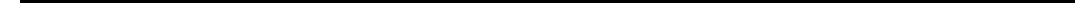
Fig. 4 – The Cre/ loxP system and its applications. The loxP site, symbolized by a triangle is a sequence of 34 base pairs composed of palindromic sequences of 13 pb separated by a sequence of 8 pb (A). Cre recombinase specifically recognizes this sequence, provokes the cleavage in DNA (vertical arrows, A) and induces the recombination of DNA between the two loxP sites as illustrated in B. This reaction is reversible. Several types of recombination events can be produced depending on whether the two loxP sites are carried by the same DNA molecule (recombination in cis) or by two different DNA molecules (recombination in trans) and depending on the respective orientation of the two loxP sites (the orientation of a loxP is given by the non-palindromic 8 pb sequence). Recombination in cis (C). If the two loxP sites have the same orientation, the DNA region situated between these sites is deleted during recombination. This type of configuration is used to create ‘‘clean’’ mutations (elimination of the selection cassette, see Fig. 3), conditional mutations (see Fig. 5) and deletions. If the orientation of the two loxP sites is opposed, recombination leads to the inversion of the region comprised between the two sites. Recombination in trans (D). If one loxP site is integrated in the genome and the other is carried by a circular plasmid, there may be an insertion of sequences carried by the plasmid in the integrated loxP site. However, since the insertion is a rare event compared to deletion (i.e., the reverse reaction), this type of event requires the use of mutant loxP sites (see Conclusions/Perspectives). When the loxP sites are both integrated in the genome, recombination in trans induces chromosomal rearrangements: deletions, duplications or translocations. Such recombination events are rare and have to be selected to be revealed. To do so, one can use truncated and non-functional hp- loxP and loxP -rt selection cassettes. After recombination between the loxP sites, and only in this case, a functional hp- loxP -rt cassette (the remaining loxP site is situated in an intron) is reconstituted, thus allowing selection of the chromosomal rearrangement desired. Furthermore, the relative orientation of loxP sites compared with the centromeric telomeric axis of the chromosomes is important. Indeed, in the case of wrong relative orientation, recombination will result in the formation of acentric or dicentric chromosomes, which, in view of their great instability, will be eliminated from the